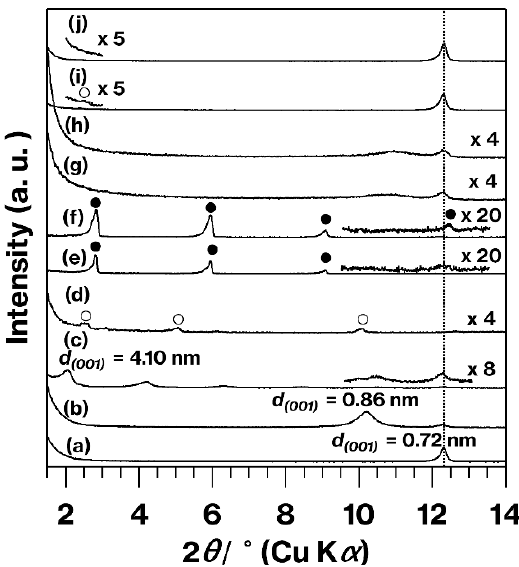
Figure 1. XRD patterns obtained from (a) kaolinite, (b) MeO-Kaol, (c) C18TAC/MeO-Kaol, (d) C18TAC, (e) C18TAB/MeO-Kaol, (f) C18TAB, (g) C18TAC/MeO-Kaol_Wash, (h) C18TAB/MeO- Kaol_Wash, (i) C18TAC/kaolinite, and (j) C18TAC/kaolinite_Wash. Reflections due to C18TAC and C18TAB are marked as open and closed circles, respectively. For (c), (e), (f), (i), and (j), adequately enlarged patterns in some 2 θ ranges are shown above each original pattern.